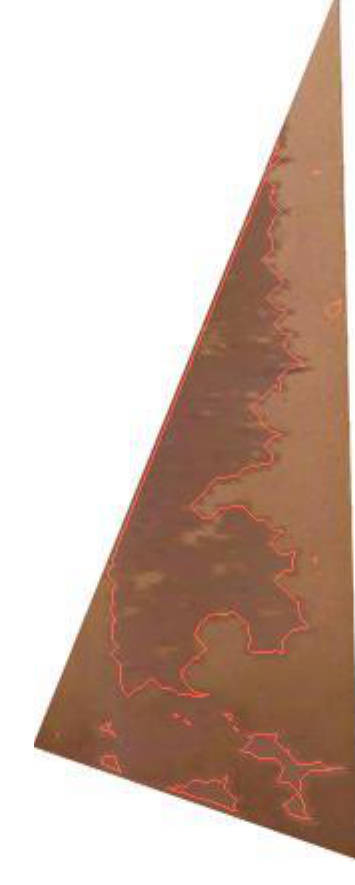
Figure 10. The upper-right triangle of new image of test 2: the stain is well detected and